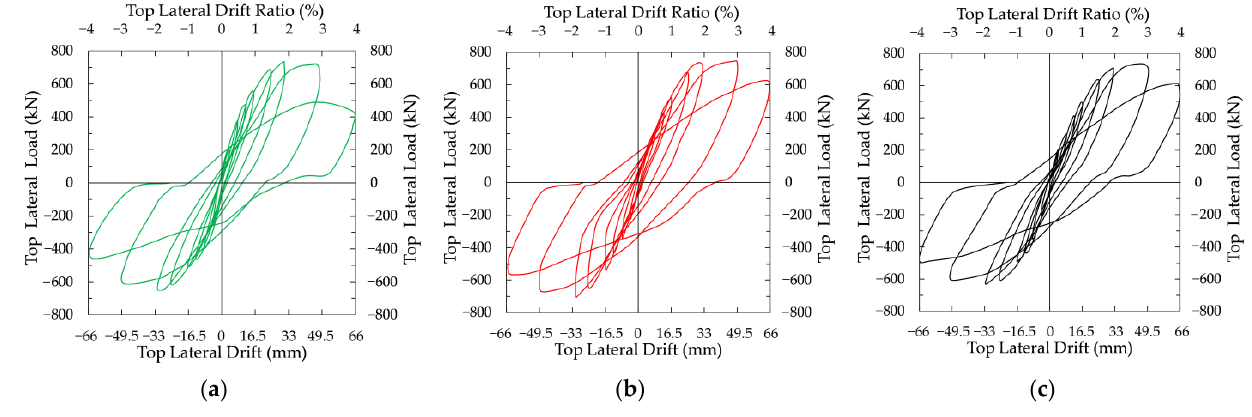
Figure 15. Hysteretic loops of s ubassemblies. ( a ) CS-1; ( b ) CS-2; ( c ) CS-3.